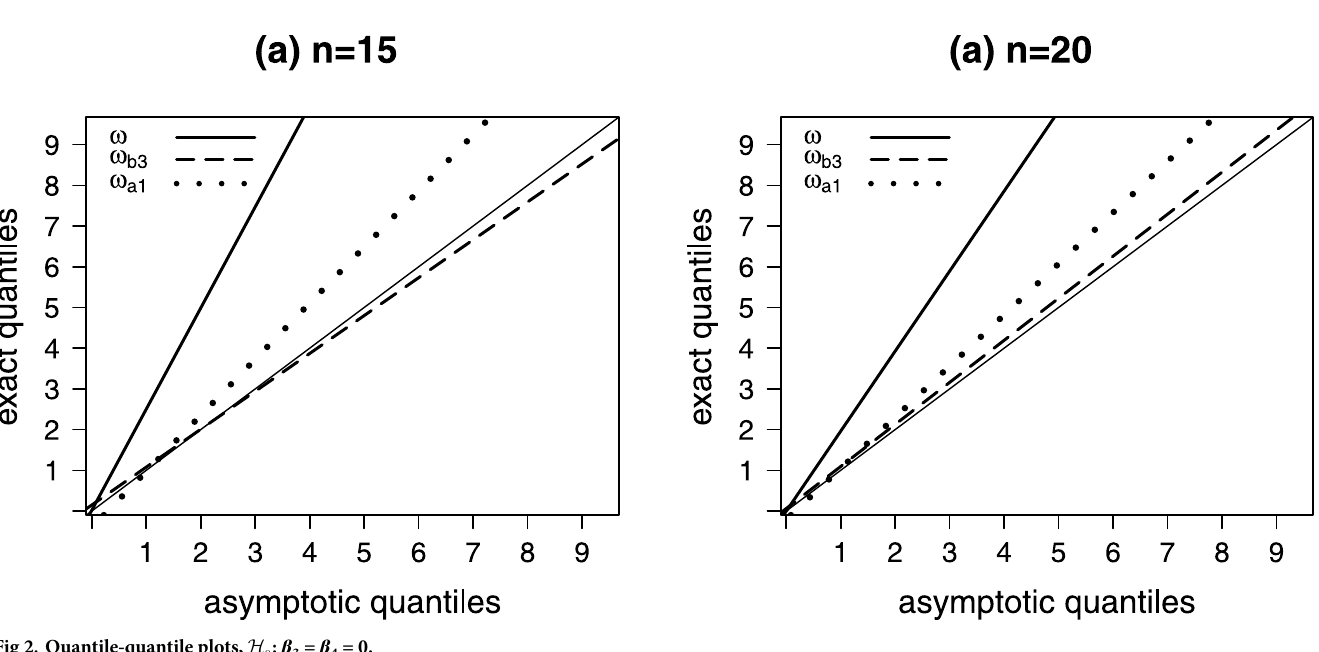
Fig 2. Quantile-quantile plots, H